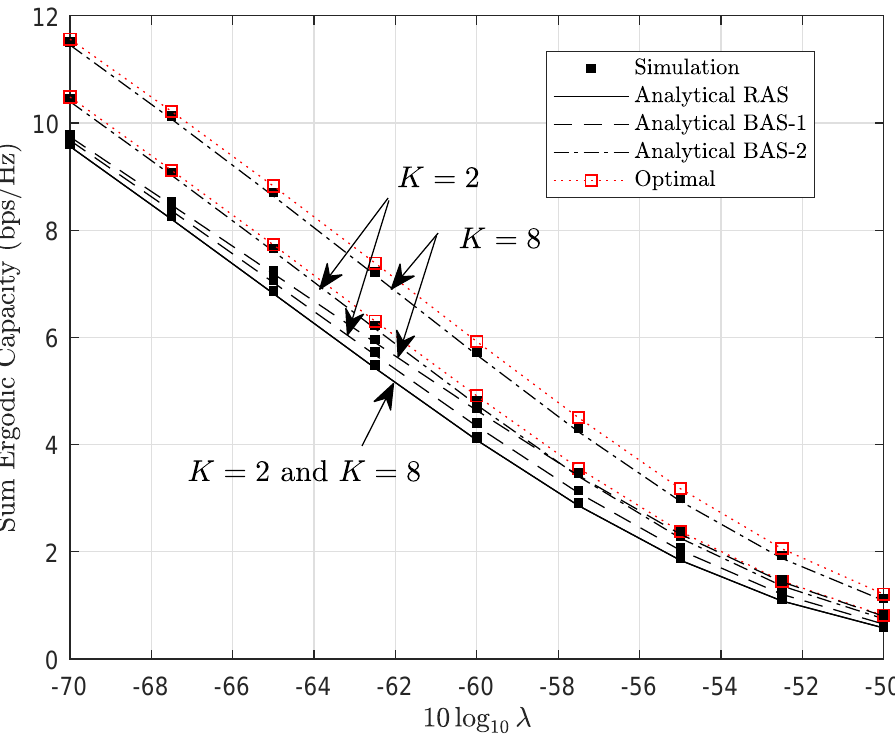
Figure 5. Sum Ergodic Capacity versus the interferer density, where λ = λ 1 = λ 2 and ¯ γ = 1.